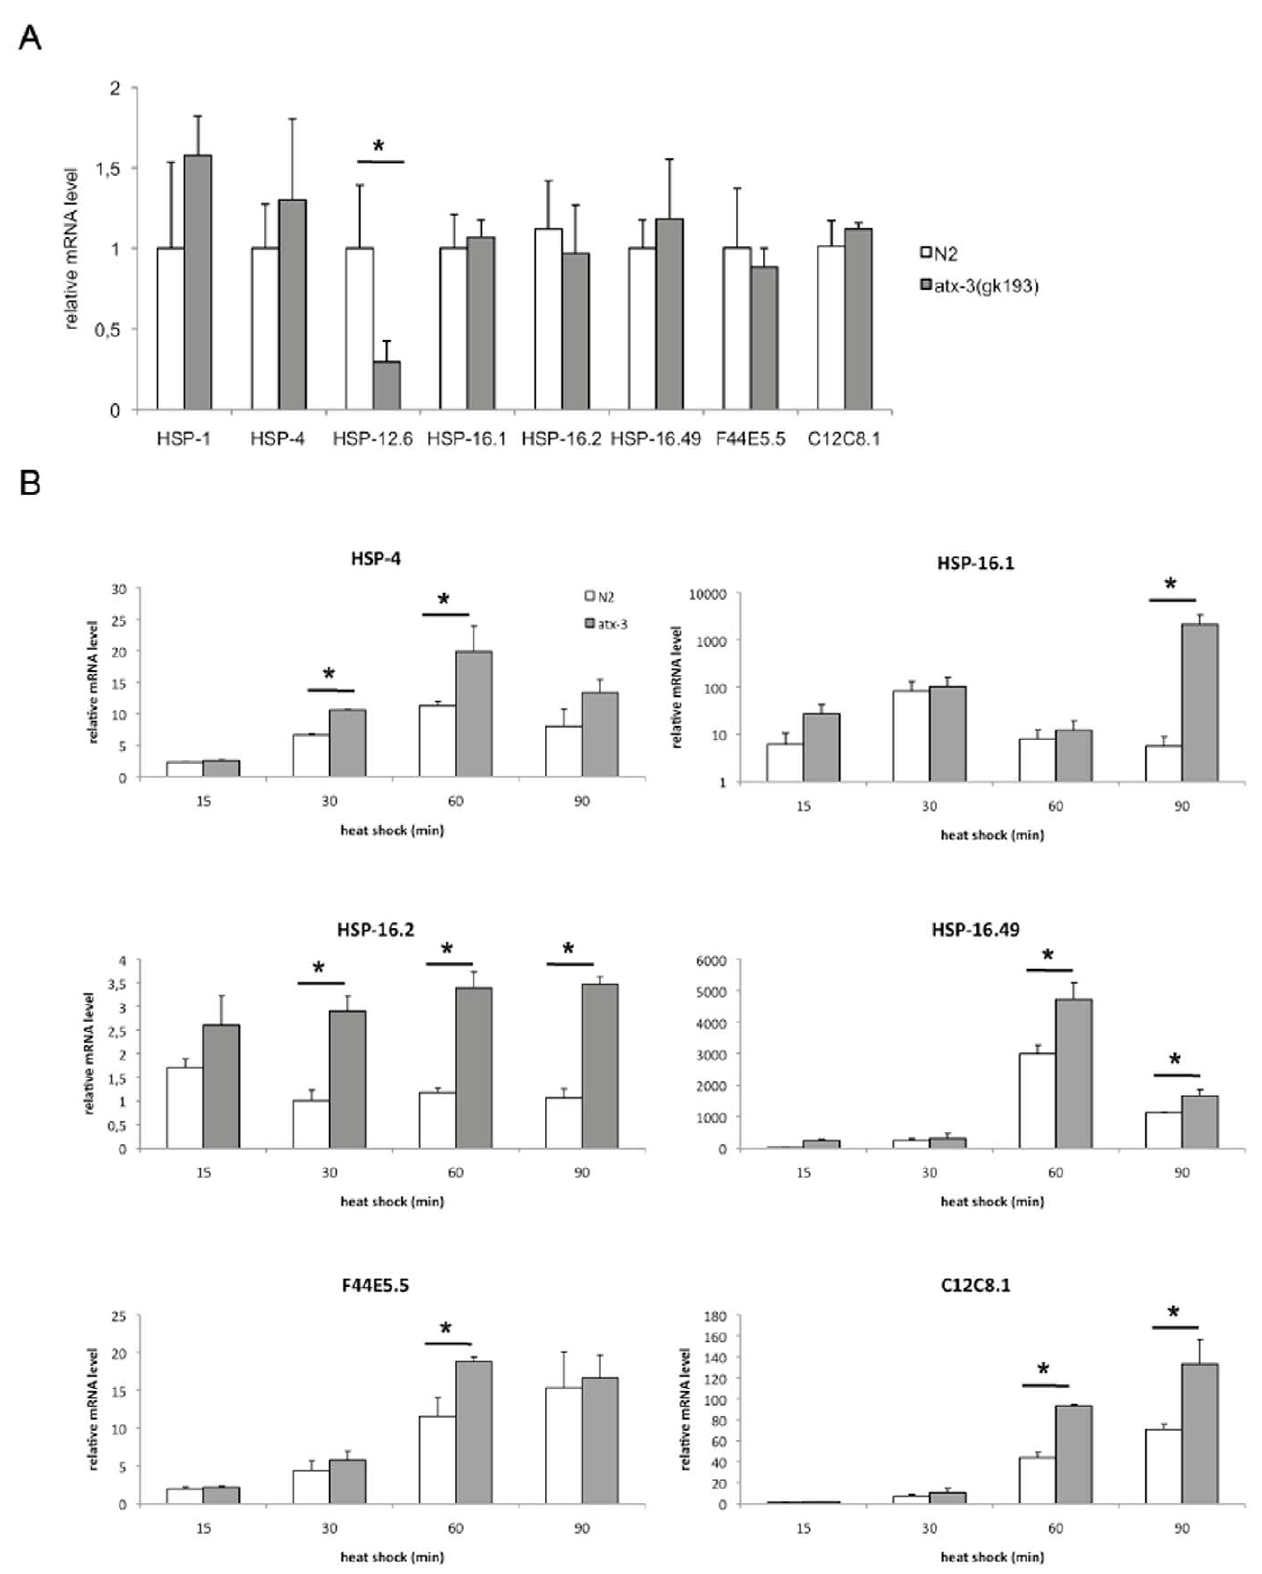
Figure 2. Atx-3 knockout animals display increased up-regulation of molecular chaperones upon heat stress at mRNA level. ( A ) At 20 u C, atx-3 mutants do not show any significant difference in the levels of several molecular chaperones, although HSP-12.6 shows a trend to be down-regulated. ( B ) Atx-3 mutants have mRNA up-regulation of several chaperones during the course of heat shock (HS) as measured by Real-Time PCR in young adult animals. HSP-4 was up-regulated from 30 until 60 minutes after the beginning of the HS and returned to wild type levels at